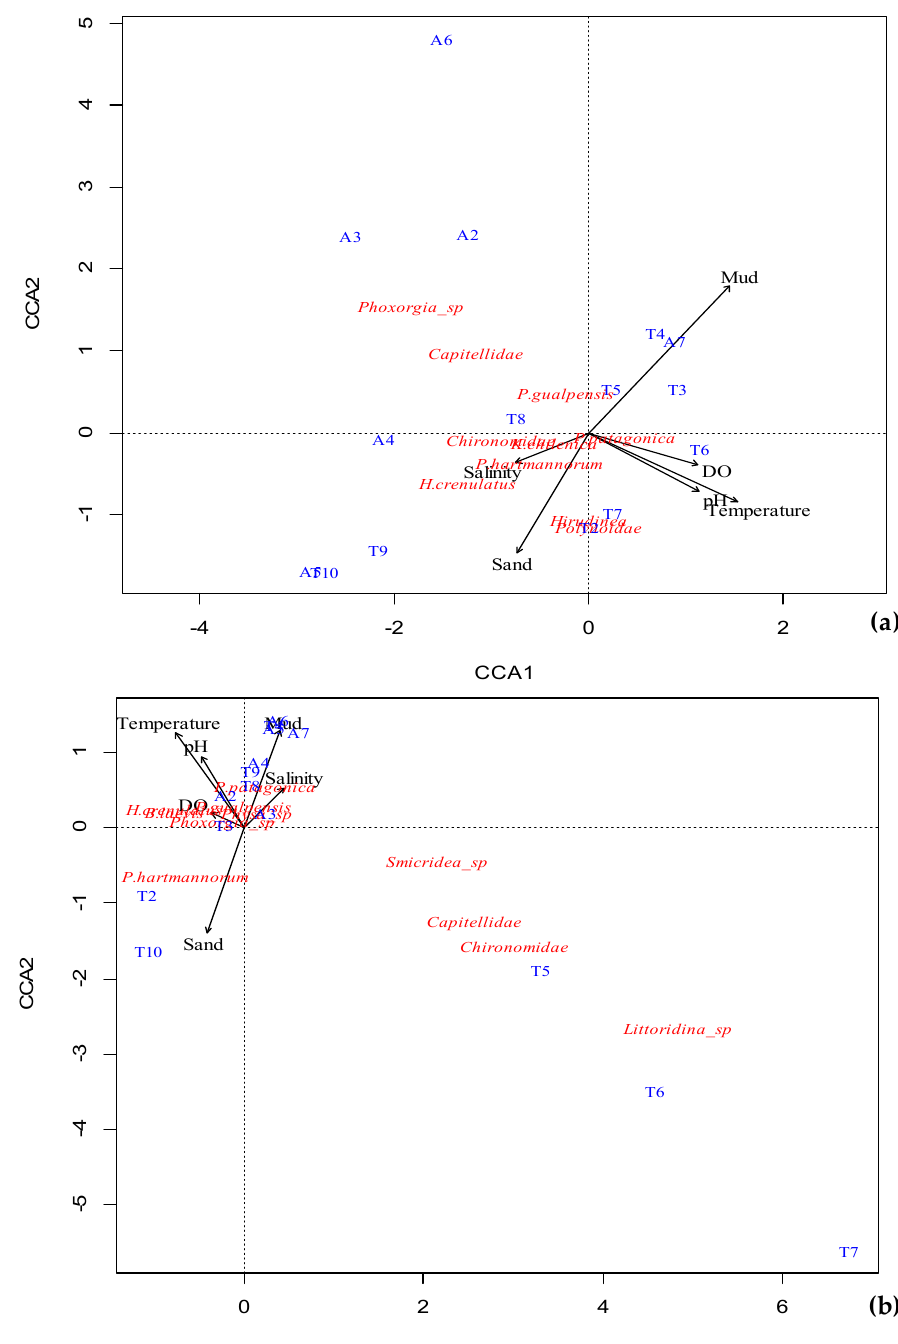
Figure 8. Canonical correspondence analysis (CCA) triplot for macroinvertebrates in summer ( a ) and winter ( b ). These plots illustrate the relationships between environmental variables and individual taxa for sampling stations in the Rocuant-Andalién and Tubul-Raqui wetlands.